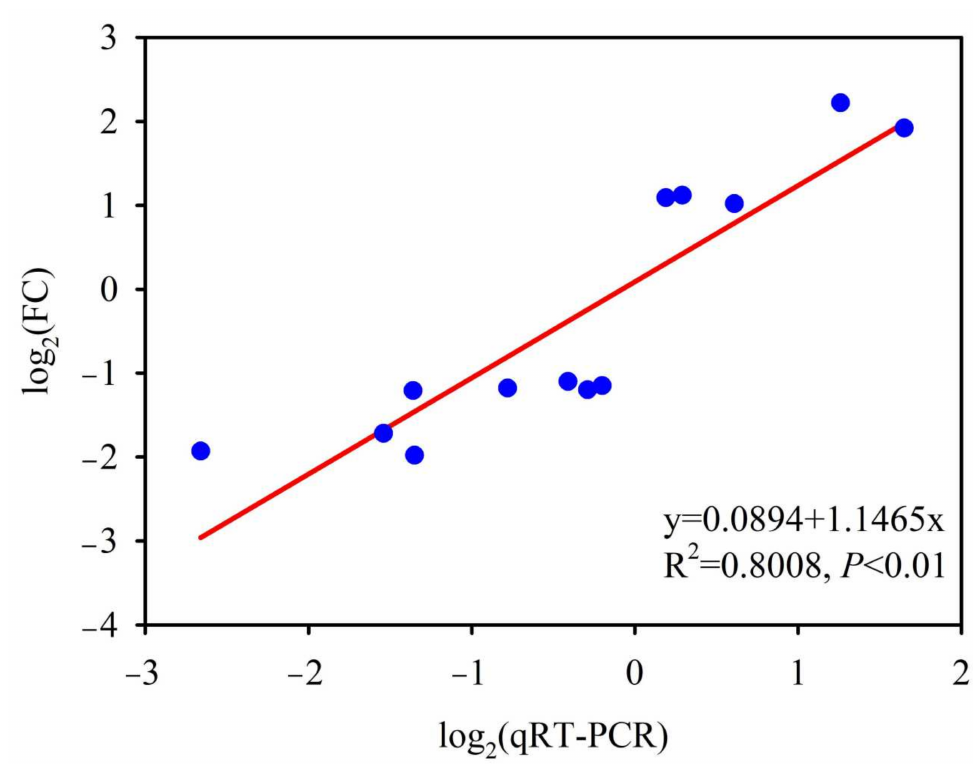
Figure 7. Validation of transcript expression changes by qRT-qPCR. The figure is based on log 2 fold change of qRT-PCR and log 2 fold change of RNA-seq. The linear trend line and the R 2 -value are